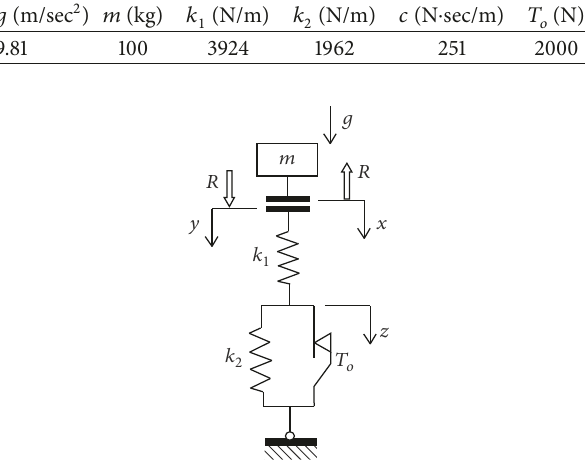
Figure 6: Visualization of elastoplastic